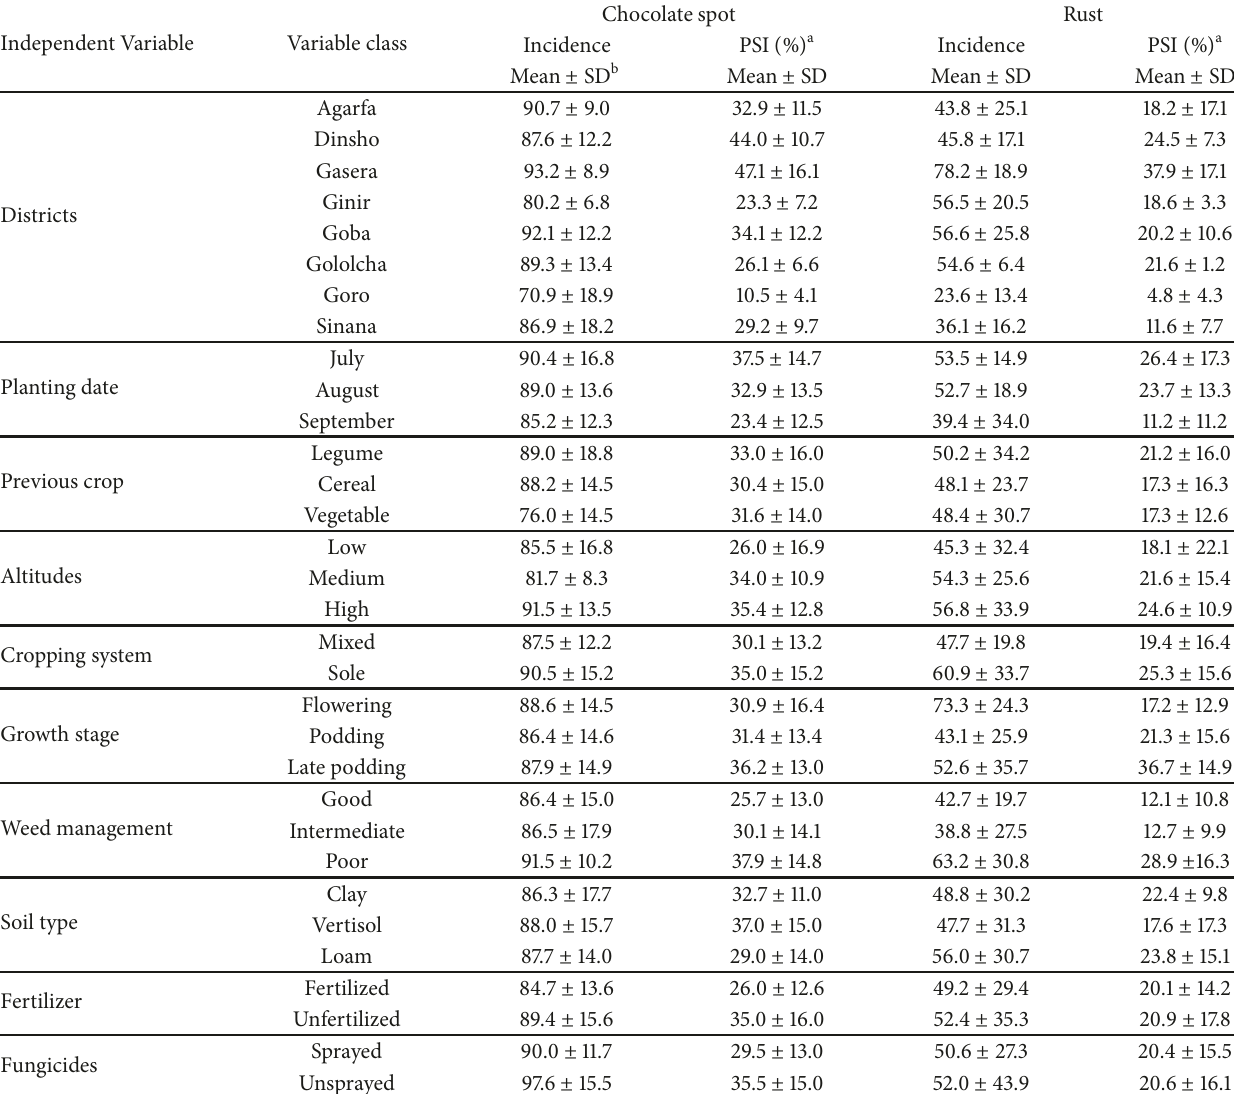
Table 3: Mean incidence and percentage severity index (PSI) of faba bean chocolate spot and rust for different independent variables during 2017 main cropping season in Bale highlands, south eastern